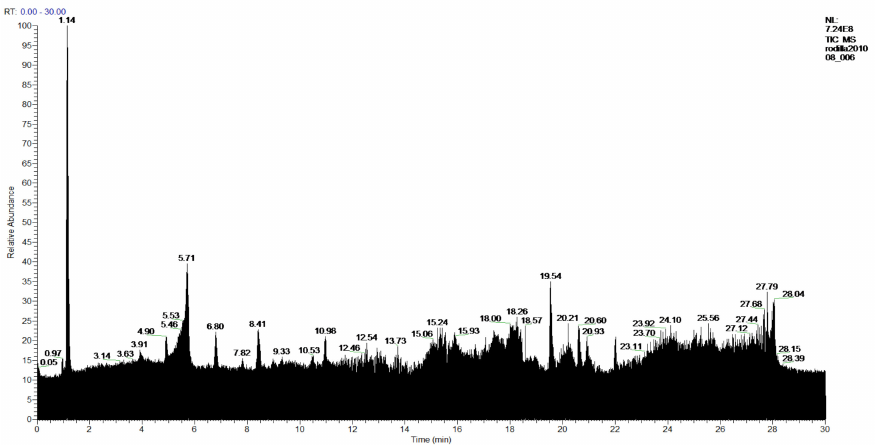
Figure 12. Chromatogram of 1-Ethanol extract from P. hypoleucinum .